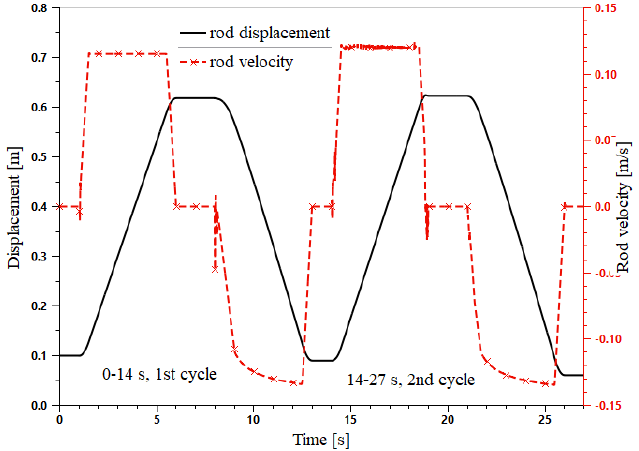
Figure 12. The boom cylinder rod velocity and displacement of the proposed system without useful load.